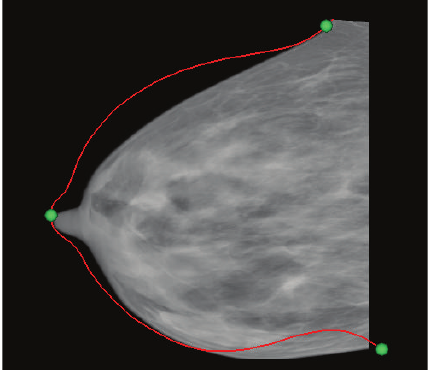
Figure 5: The mammogram of Figure 4 following preliminary alignment with contour and landmarks from the MRPI